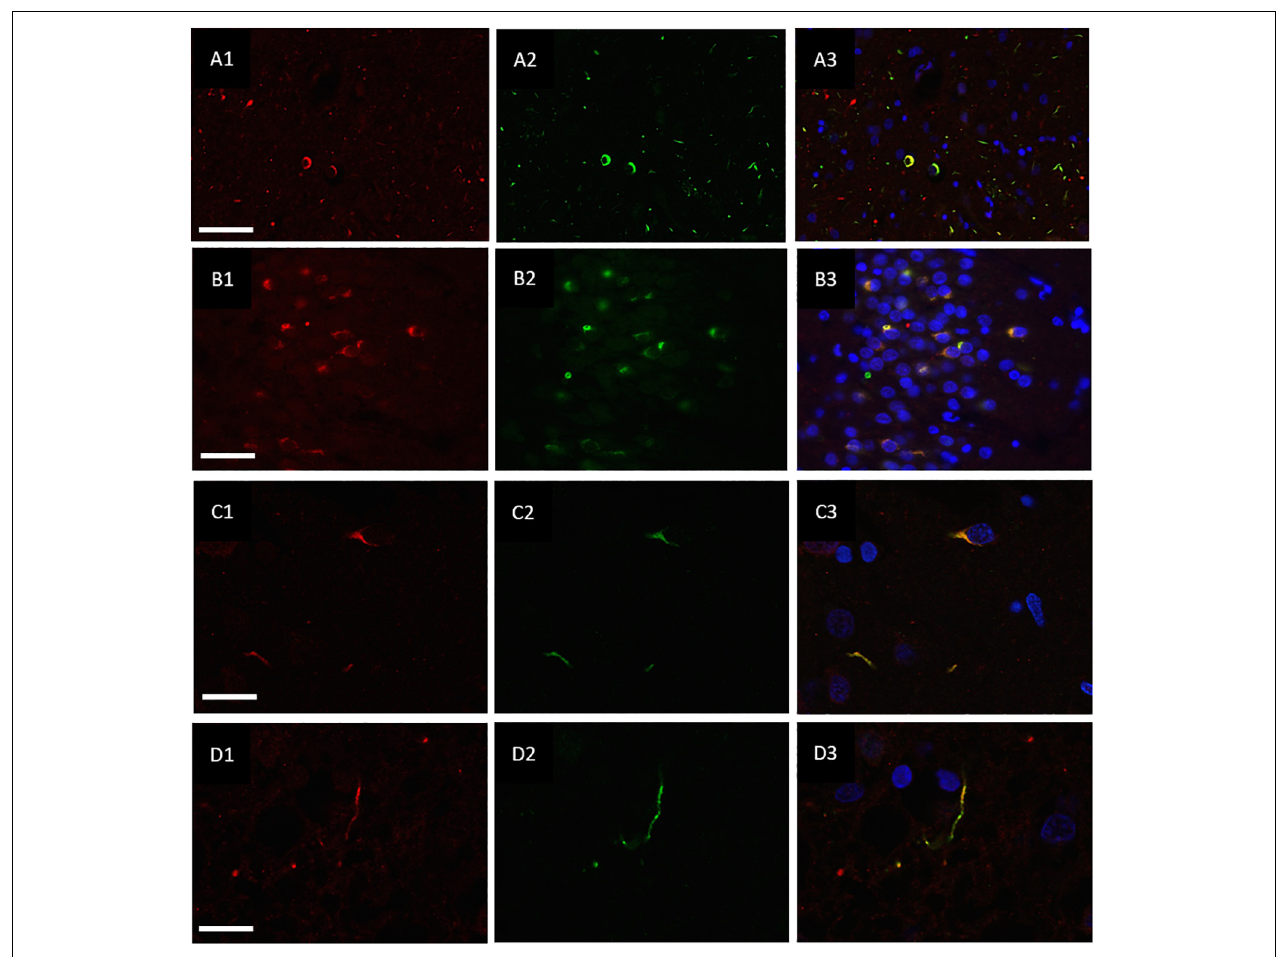
FIGURE 3 | Co-localisation of ubiquitin and hnRNP E2. Double-labeling immunofluorescence of Ubiquitin (red) and hnRNP E2 (green) shows high levels of co-localisation within the frontal cortex (A1–A3) and hippocampus (B1–B3) of a subtype A case (case ID BBN_4568). Strong co-localisation can be seen within the inclusions in a subtype A case (C1–C3) (case ID BBN_15298). In a subtype C case, some inclusions show only ubiquitin positivity (D1) and some only hnRNP-E2 positivity (D2) . Within inclusions showing both proteins, the co-localisation is not absolute (D3) (case ID BBN_15303). Scale bar represents 80 µ m in panel (A1–A3) , 50 µ m in panel (B1–B3) , 20 µ m in panels (C1–C3,D1–D3)